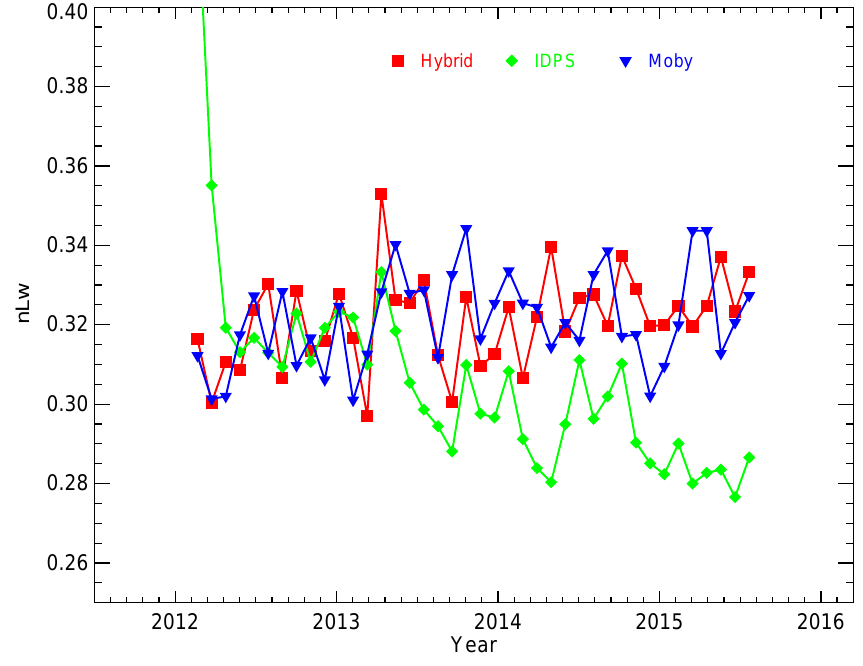
Figure 16. Ocean nL w ( λ ) trending for the band M4 along with MOBY in situ data.